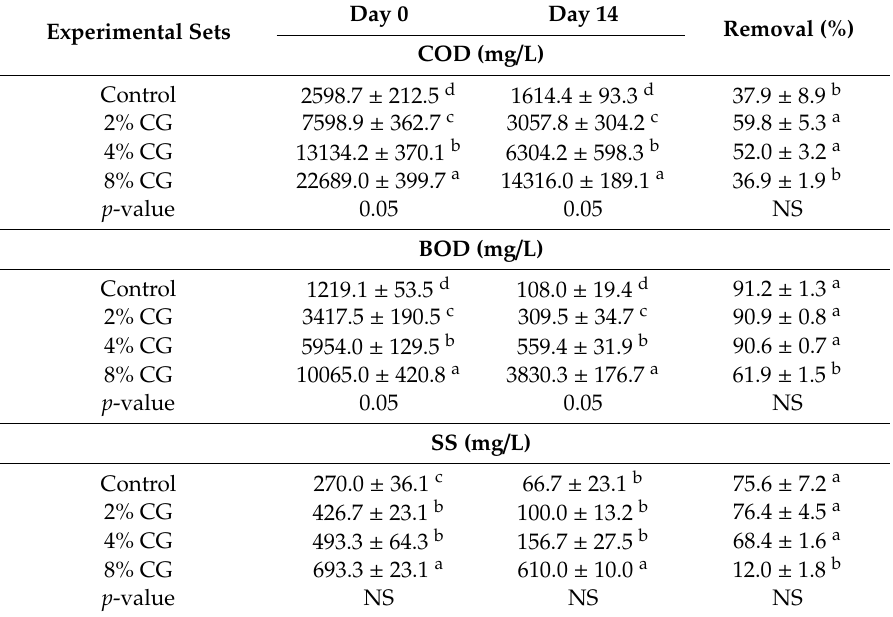
Table 3. Changes of the chemical oxygen demand (COD), biochemical oxygen demand (BOD), and suspended solids (SS) removal e ffi ciency for the liquid digestate of all digesters with di ff erent addition ratio of crude